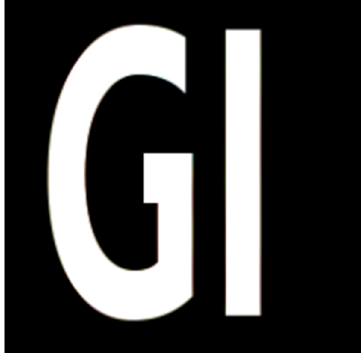
Figure 5. The expected object: ‘GI’ pattern.